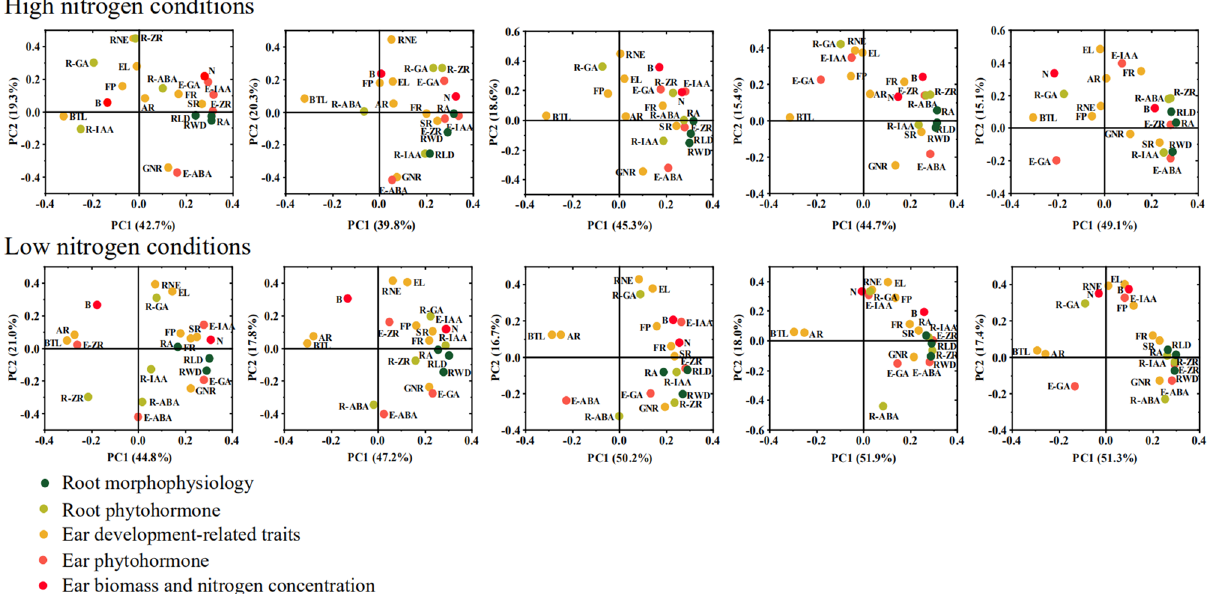
Figure 7. Principal component analysis (PCA) of ear differentiation and development traits, ear and root phytohormones, root morphological and physiological traits determined on maize varieties during critical ear differentiation